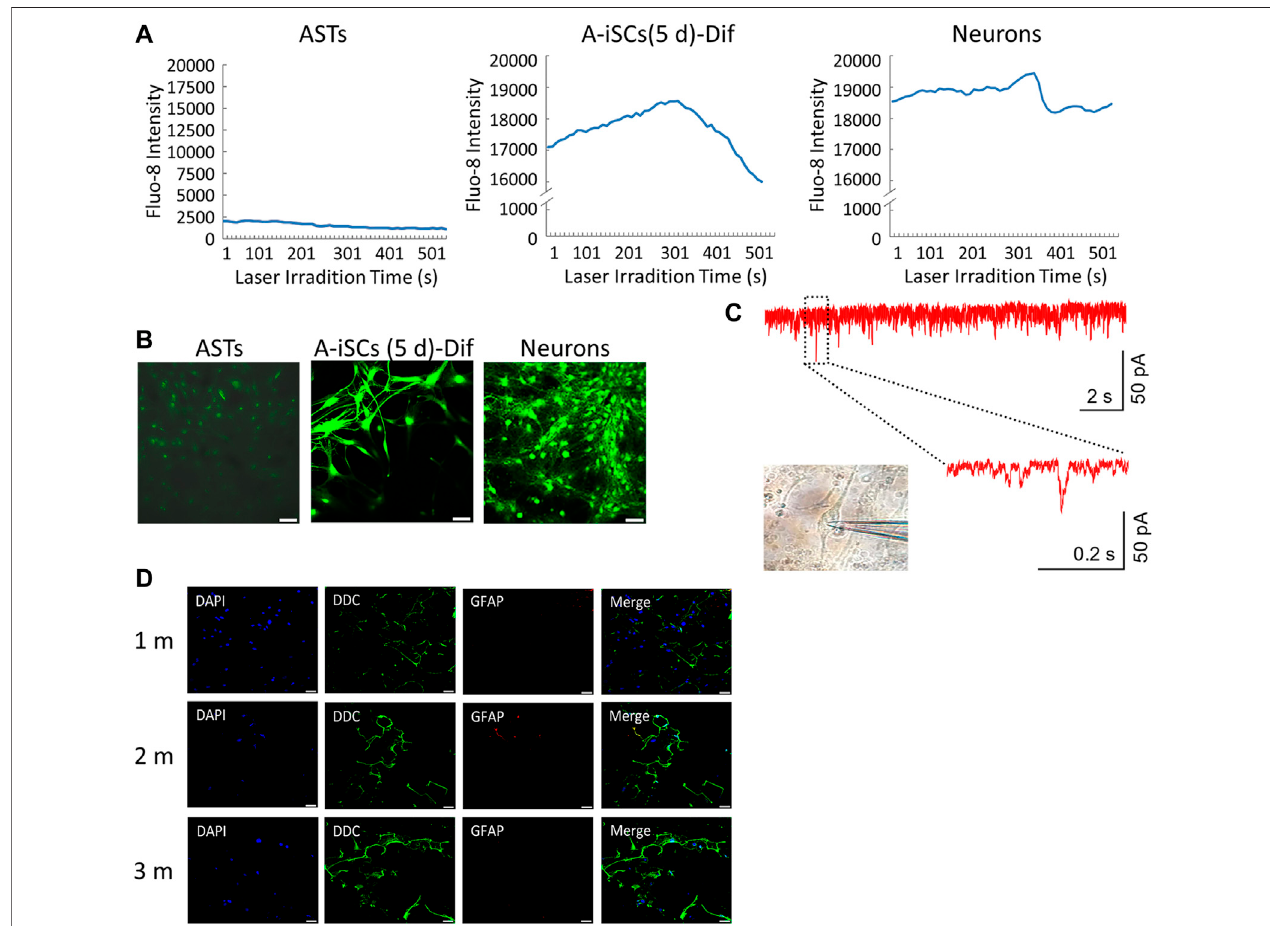
FIGURE 4 | Functional analyses of A-iSCs-converted neurons. (A) Comparison of the patterns of synchronized Ca 2+ spikes among monolayer ASTs, A-iSCs- derived neurons, and naive neurons. (B) Fluorescent calcium imaging of monolayer ASTs, A-iSCs-derived neurons, and naive neurons. Scale bar: 50 μ m. (C) Representative traces showing spontaneous synaptic events in A-iSCs-derived neurons. (D) A-iSCs-derived neurons showing an increased number of synaptic puncta along the dendrites over time. m, month. Scale bar: 50 μ m.